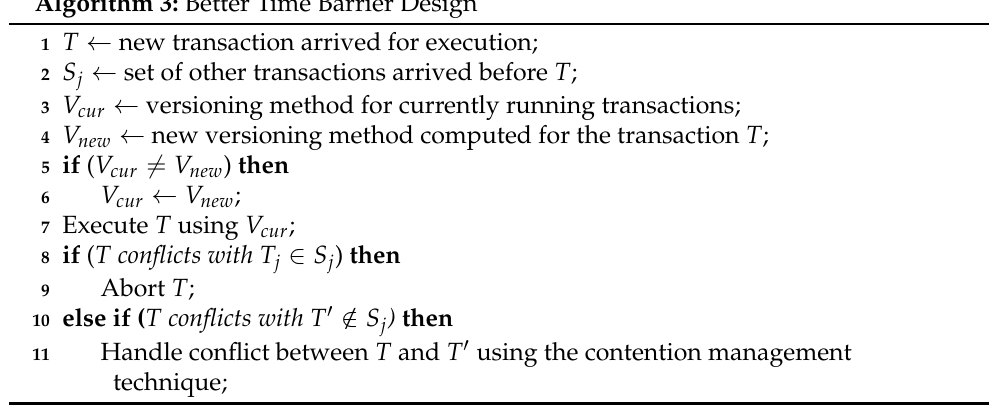
Figure 6. An illustration of the better switching mechanism. λ ∗ represents the time interval in which versioning is not switched. δ ∗ resembles better time barrier of Figure 5. Algorithm 3: Better Time Barrier